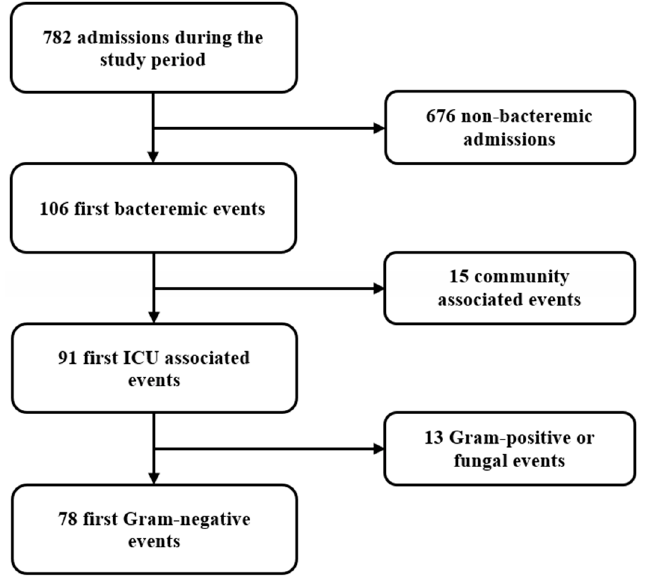
Figure 1. Study flowchart.